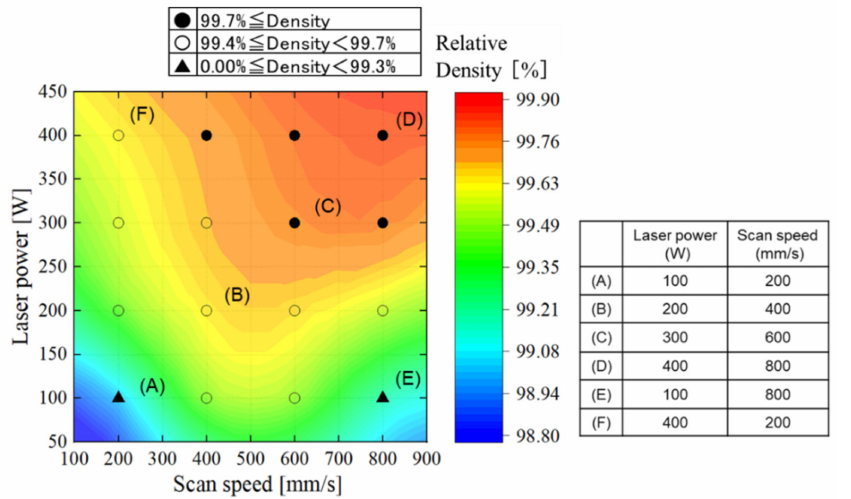
Figure 6. Density-based process map in terms of laser power and scan speed using the as-built cubic specimens fabricated at various conditions.